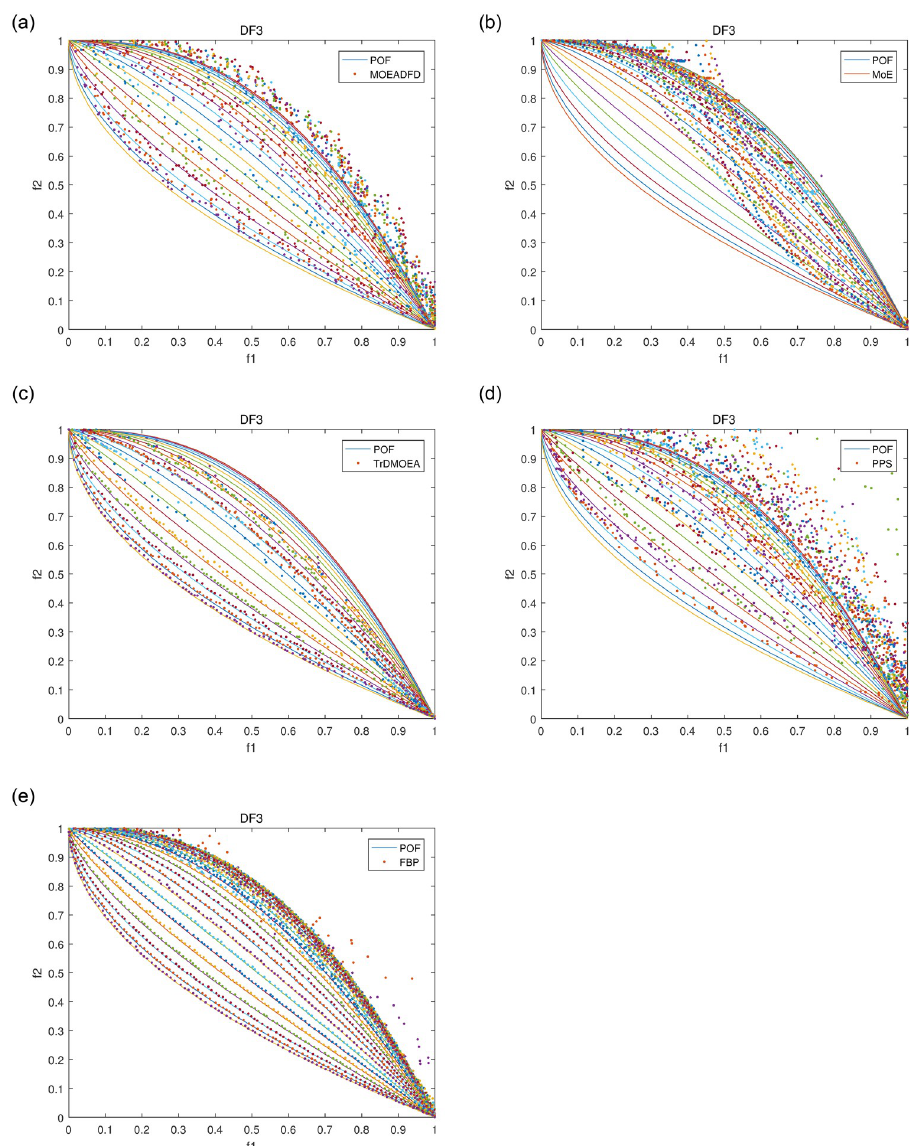
Fig 4. POF approximations of five algorithms for DF3 with n t = 10 and τ t =